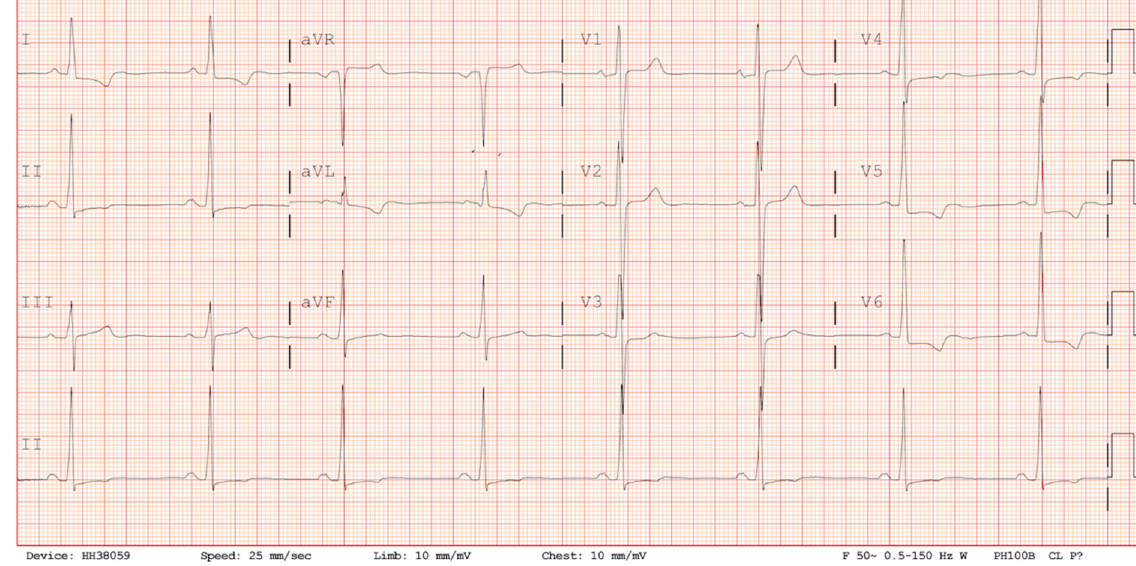
Figure 2. A 12-lead electrocardiogram demonstrating sinus rhythm, normal axis, preterminal negative T waves in I, avL, V4-V6, RS conversion in V3/V4 and ST-segment depression in V5 and V6, reflecting anterolateral repolarisation abnor- malities.